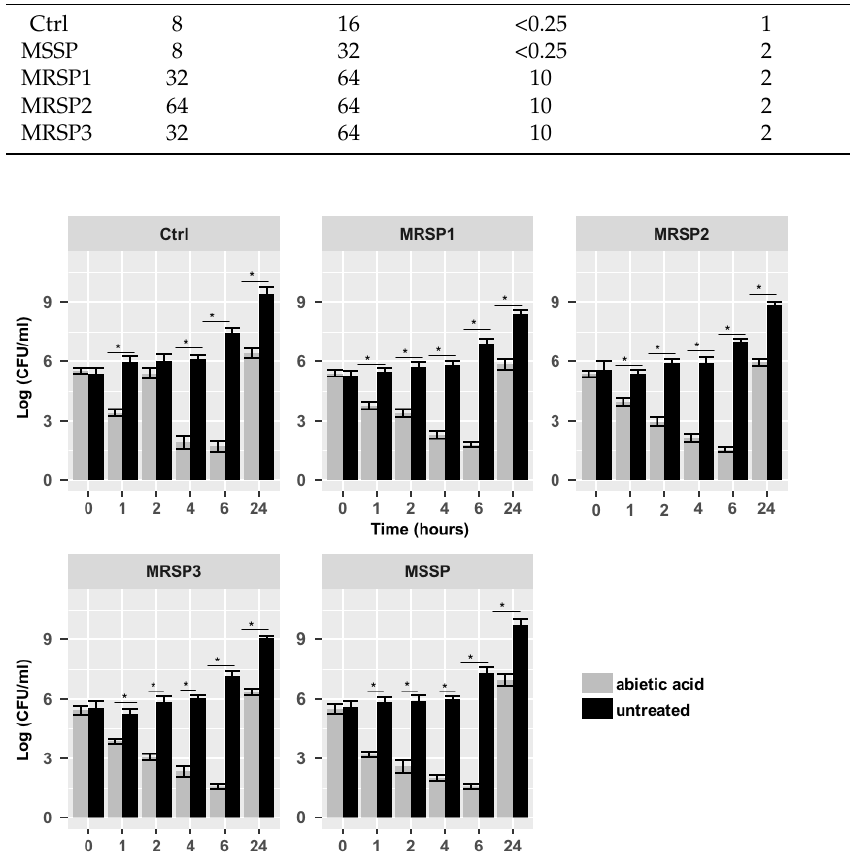
Figure 1 . Time-kill assay of abietic acid against Ctrl, MRSP1-3 and MSSP strains. Each experiment is the result of three independent experiments performed in triplicate. Ctrl: human antibiotics susceptible S. pseudintermedius strain; MSSP: veterinary methicillin-susceptible strain; MRSP1: veterinary methicillin-resistant S. pseudintermedius strain; MRSP2 and 3: human methicillin-resistant S. pseudintermedius strains. * represents p < 0.05.